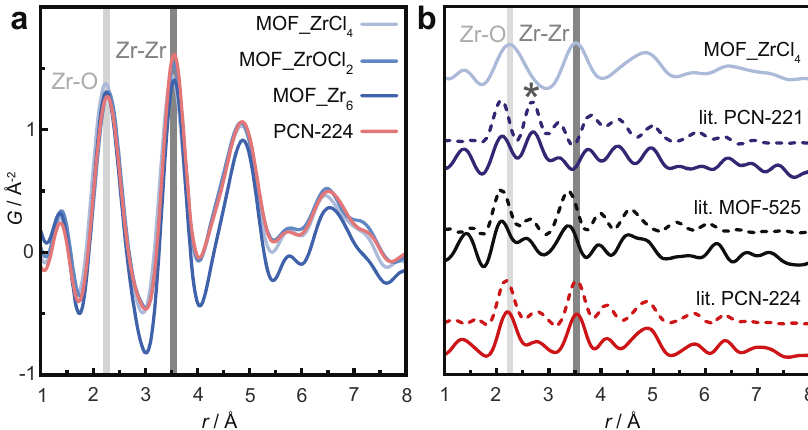
Fig. 3 Local structures of MOF samples and models. a Experimental pair distribution functions (PDFs) of MOF_ZrCl 4 , MOF_ZrOCl 2 , MOF_Zr 6 , and experimental PCN-224; b experimental PDF of MOF_ZrCl 4 compared to the simulated PDFs (lit.) of the published MOF structures (solid line) and SBUs only (dashed line) of PCN-224, MOF-525, and PCN-221 17,21,22 . The star highlights the Zr – Zr distance of 2.69 Å in PCN-221.